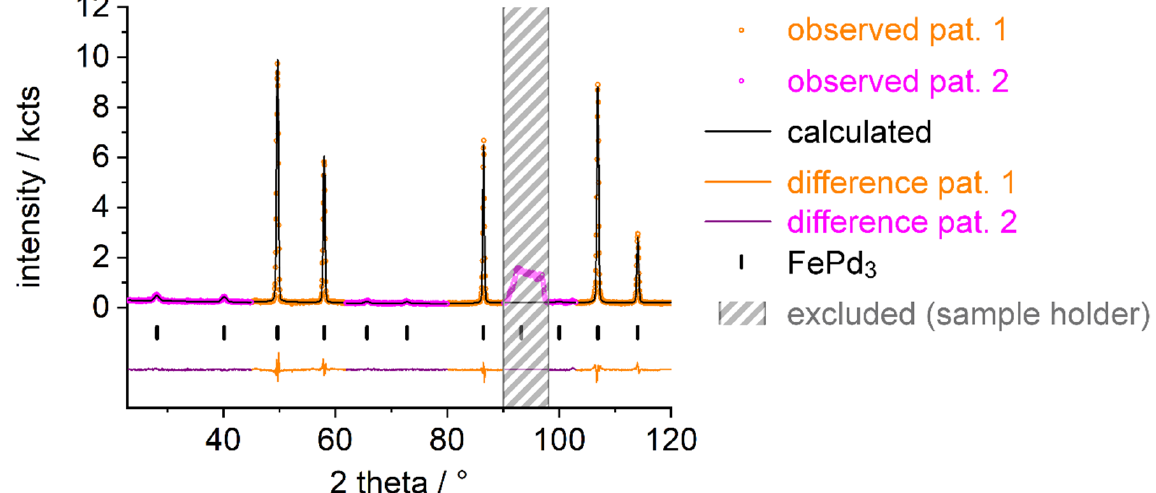
Figure A27. Rietveld refinement of the crystal structure of FePd 3 D 0.045(10) (for details, see fifteenth row in Tables A8 and A9) based on neutron powder diffraction data (NUMOR 131894 [21], λ = 186.80(2) pm, D20 ILL, Grenoble) in a single-crystal sapphire cell at 313(1) K and 8.00(1) MPa deuterium pressure using FullProf [24].